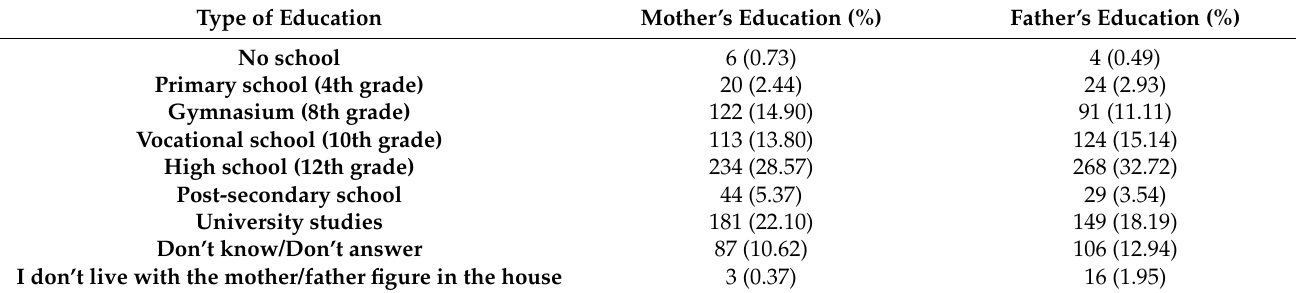
Table 2. Sample description according to mother’s and father’s